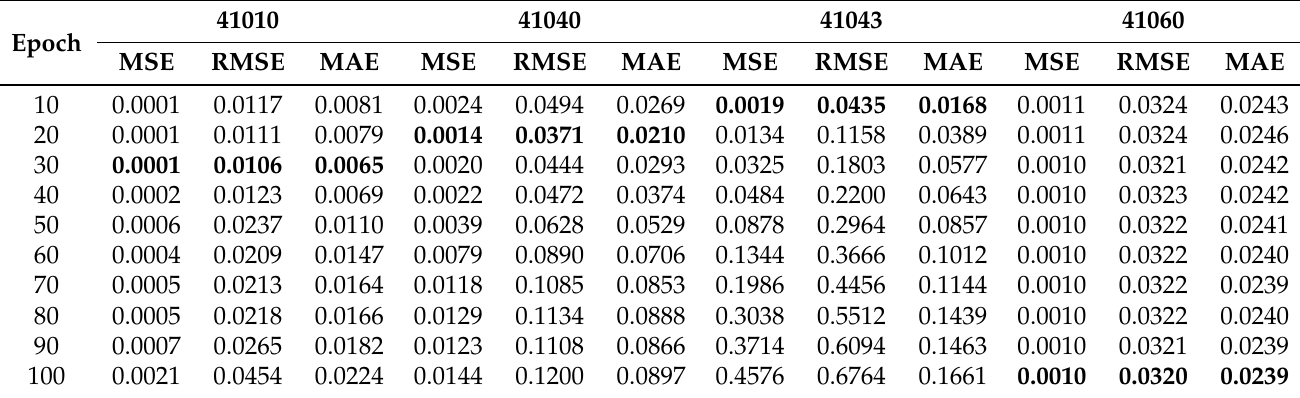
Table 6. Results of the proposed LSTM-SCA model in all datasets.